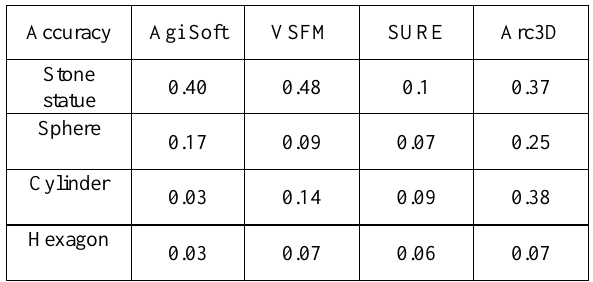
Table 3 - Accuracy for Nikon D3200 sensor